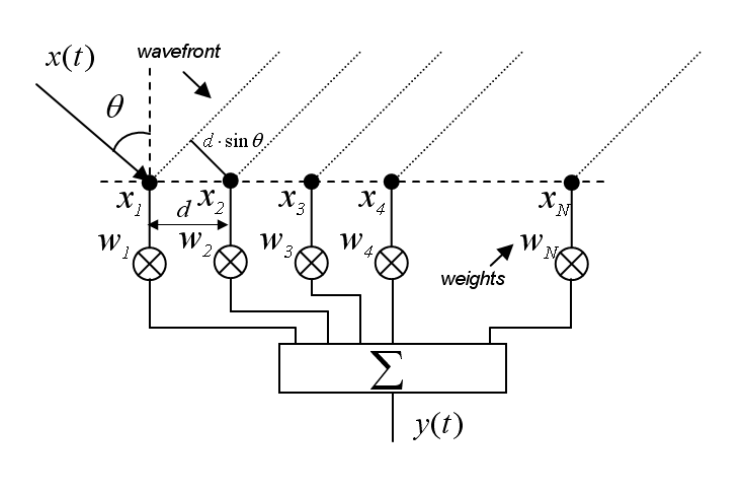
Figure 1. Structure of a